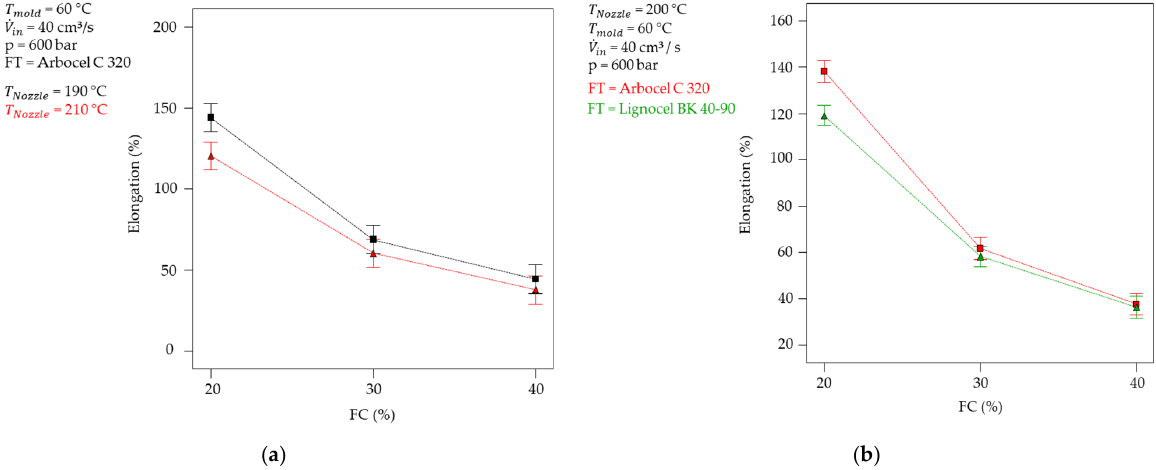
Figure 9. ( a ) Elongation of wood ‐ filled TPU as a function of fiber content and temperature control. ( b ) Elongation of wood ‐ filled TPU as a function of fiber content and fiber type. Table 6. p ‐ values of various test parameters for strain.